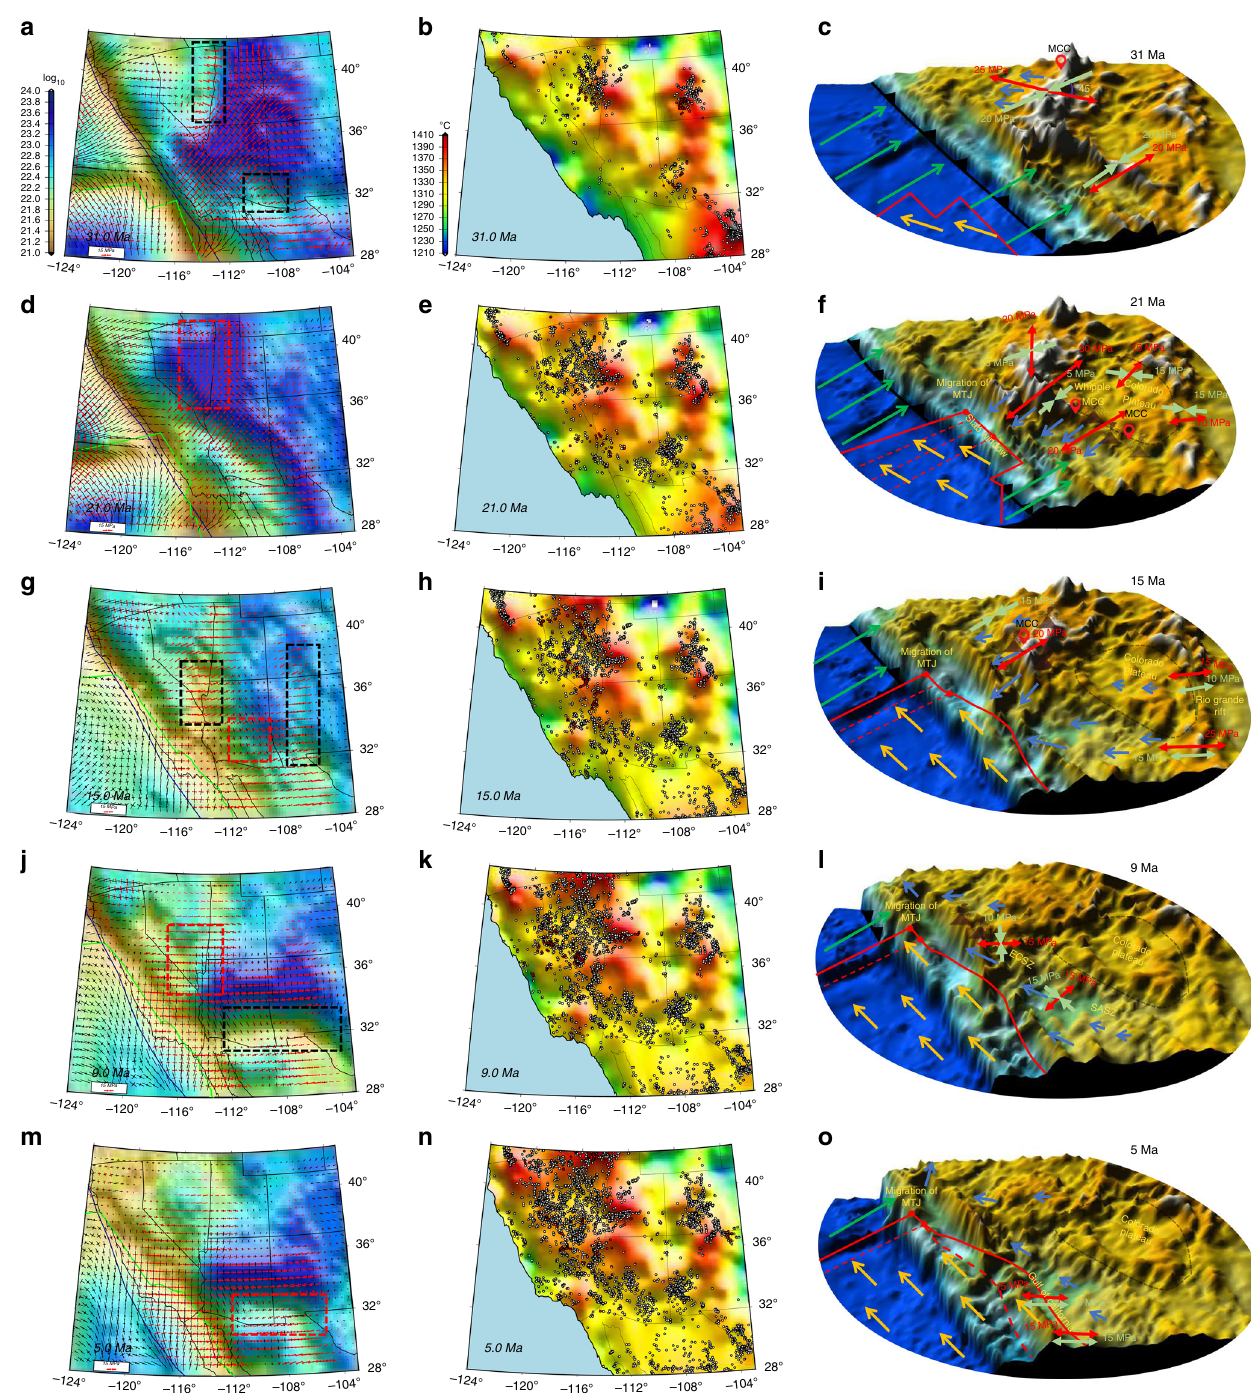
Fig. 9 Dynamically constrained re fi ned prediction of deviatoric stress and effective viscosity variations. a , d , g , j , m Time-slice maps of lithospheric effective viscosity obtained from deviatoric stresses of iterative dynamic model in southwestern North America. Red arrows represent tensional, and black arrows represent compressional principal axes of deviatoric stress tensors. Red dashed lines show the location of viscosity hardening and black dashed lines show the location of viscosity weakening. b , e , h , k , n Time-slice maps of averaged upper mantle temperature from Moho boundary to 100 km depth. Red and grey dots represent reconstructed coordinates of present-day localities of paleo-magmatism through time. Red dots represent active magmatism and grey dots represent previously active magmatism. c , f , i , l , o Time-slice 3-D perspective images of paleo-elevation in southwestern North America along with major tectonic events and driving mechanisms (direction and magnitude) responsible for extensional collapse of a distribution of high topography since Late Eocene. Light green arrows represent contractional stresses related to the accommodation of Paci fi c- and Farallon-North America relative motion. Red arrows represent tensional deviatoric stresses. Yellow vectors represent the motion of Paci fi c plate, green vectors represent the motion of Farallon plate, and blue vectors represent the motions of deforming lithosphere. All motions are relative to the North American